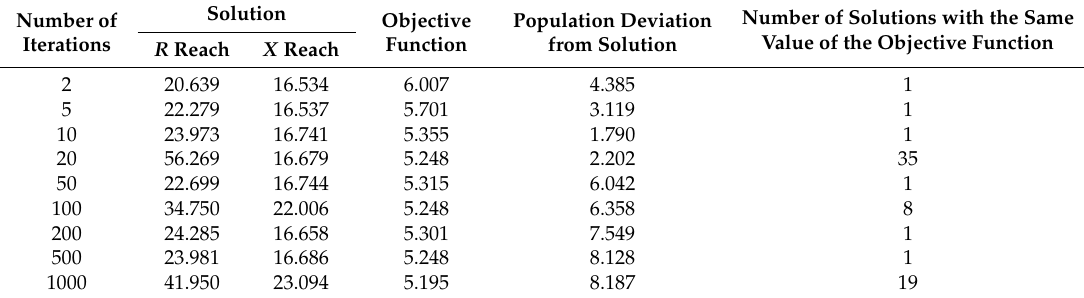
Number of Solutions with the Same Value of the Objective Function R Reach X Reach